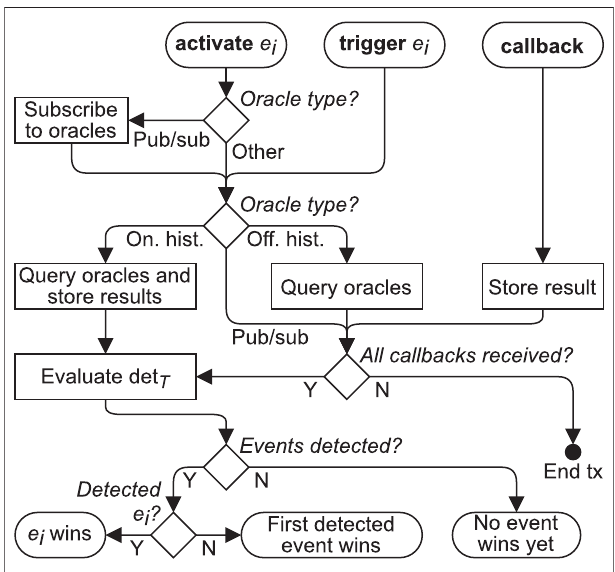
FIGURE 7 | Flowchart of the non-continual semantics